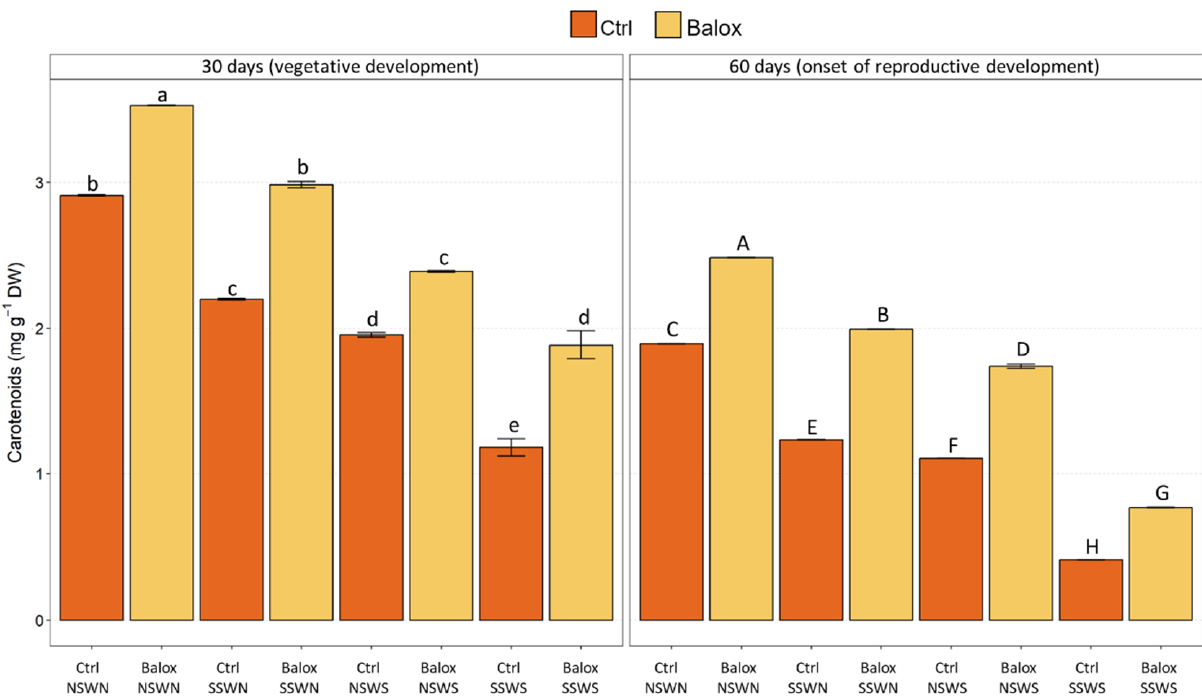
Figure 5. Carotenoids contents in tomato plants subjected to increasing salinity by different combinations of saline or non-saline soil and irrigation water; the plants were treated, or not, with the biostimulant containing polyphenols at 1.4% ( w / w ) and glycine betaine at 3.0% ( w / w ) at a dose of 0.4 mL L − 1 of irrigation water. The control treatments without biostimulant (Ctrl) and with biostimulant (BALOX ® ) are defined as follows: (i) NSWN: Non-saline soil (EC = 2.28 dS/m) and non-saline water (EC = 0.91 dS/m); (ii) SSWN: Saline soil (EC = 8.55 dS/m) and non-saline water (EC = 0.91 dS/m); (iii) NSWS: Non-saline soil (EC = 2.28 dS/m) and saline water (EC = 10.50 dS/m); (iv) SSWS: Saline soil (EC = 8.55 dS/m) and saline water (EC = 10.50 dS/m). The evaluation periods: 30 days and 60 days of treatments. The values are the means ± SE ( n = 3). Different letters above the bars (lowercase for 30 days and capital for 60 days treatments) indicate significant differences between treatments, according to the ANOVA test ( p < 0.05). Statistical analyses were performed independently for the two treatment